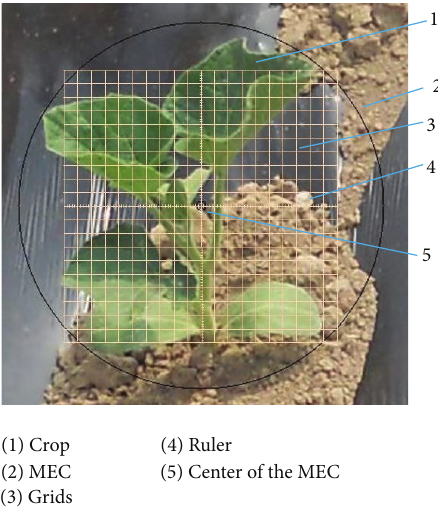
Figure 10: Printed crop